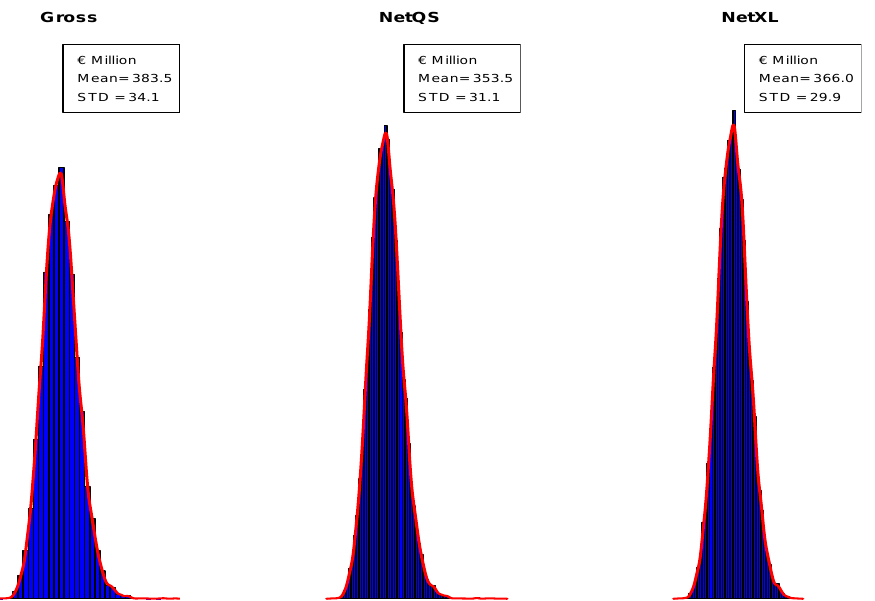
Figure 5. Simulated distributions of Total Portfolio Aggregate Claims Cost for Tau.